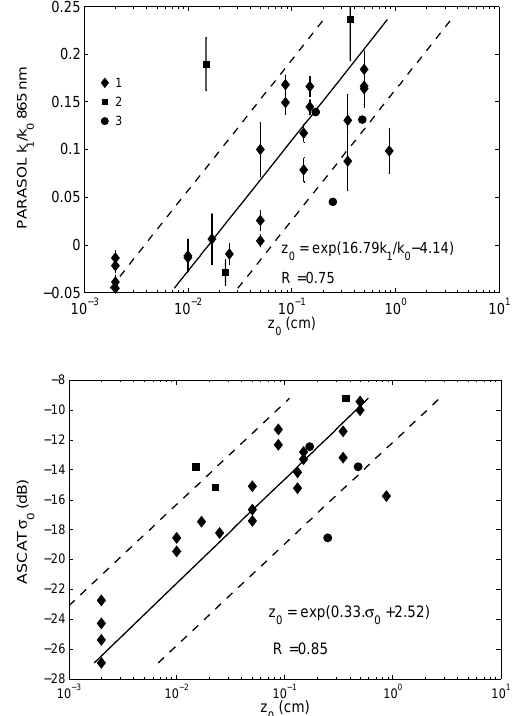
Fig. 3. Scatter plot of the selected z 0 estimates (see Table 1) versus the k 1 / k 0 PARASOL coefficient at 865nm (top panel) and the AS- CAT σ 0 (bottom panel). For PARASOL, bars indicate the standard deviation over the area. The solid line indicates the regression line, and the dashed lines the regression line plus and minus one standard deviation with respect to the observations. Diamond shapes (1) for Marticorena et al. (2004), squares (2) for Greeley et al. (1997), and circle (3) for Marticorena et al. (2006).